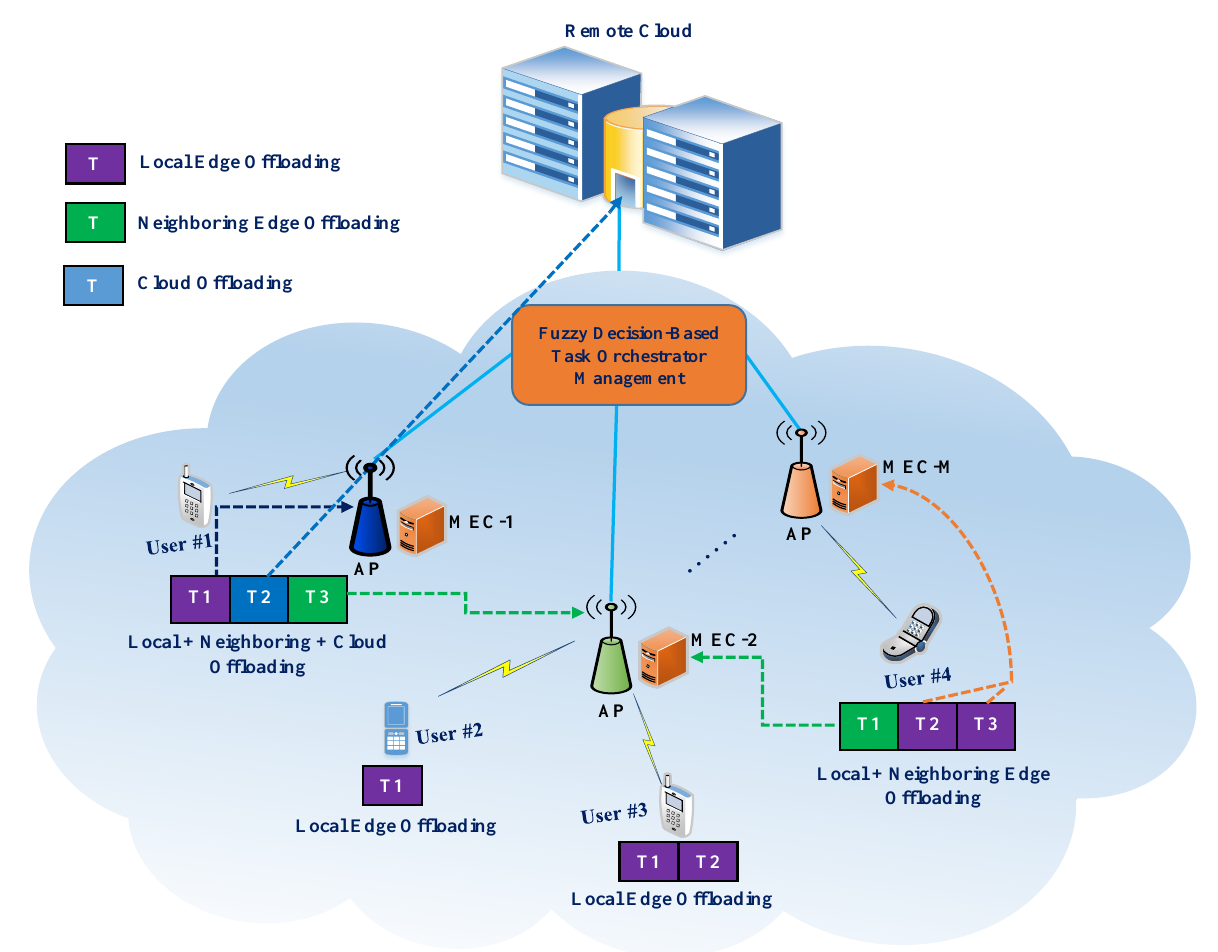
Figure 5. Proposed multi-tier MEC system